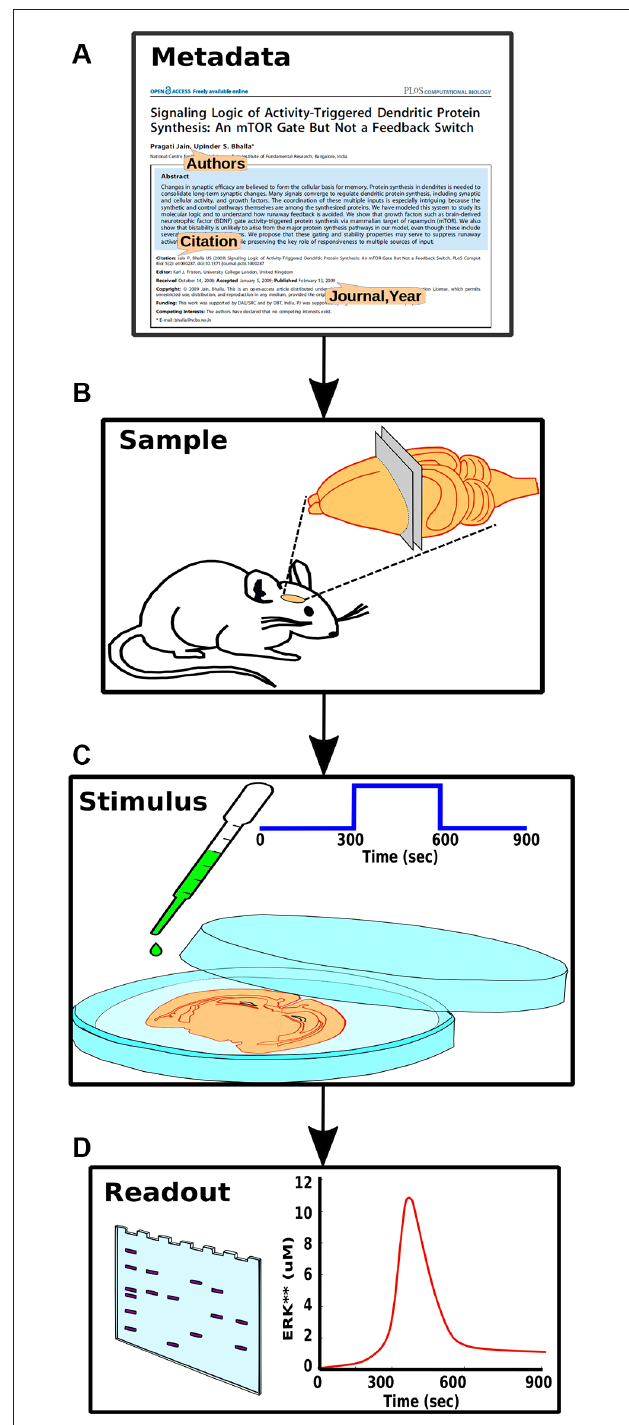
FIGURE 3 | Components of experiment specification. (A) Experiment metadata, including citation information and authorship. (B) Experimental context, including species, preparation and conditions. (C) Stimulus information such as molecular identity and concentration of a pharmacological agent. (D) Readouts from the experiment, such as a gel or time-course, each representing a set of measurables that should have a direct mapping to the